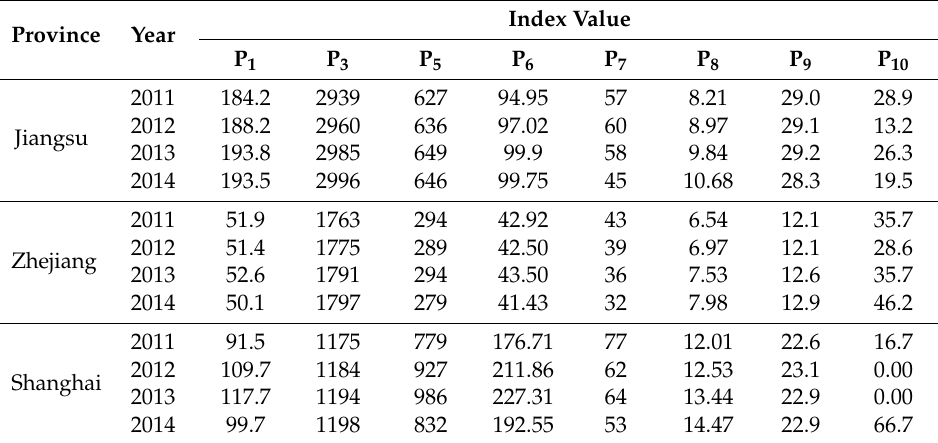
Table 2. Provincial index values of Taihu Basin during